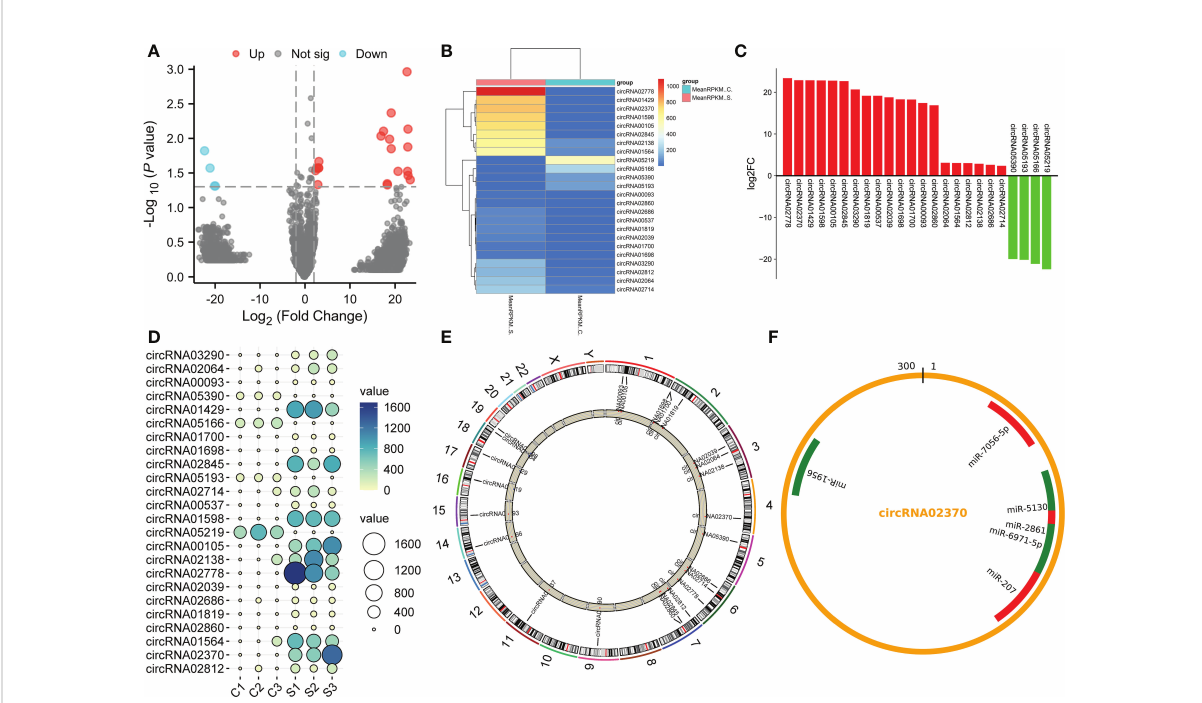
FIGURE 3 The circRNAs were differentially expressed in the subacute stage after SCI in mice. (A) Volcano plot. Green points indicate down-regulation (left side), gray points indicate undifferential expression (middle), and red points indicate up-regulation (right side). (B) Hierarchical clustering. with rows indicating DECs and columns indicating samples. (C) Bar plot shown the top 20 upregulated and 4 downregulated DECs in SCI tissues. The X-axis represents miRNA and the Y-axis represents log2 fold change. Red means up-regulation, above the X-axis; green means down- regulation, below the X-axis. (D) Ballon plot. The size of the circle shows the size of each value in the matrix, and the size of the value is represented by the shade of color. (E) The distribution of DECs on chromosomes. (F) CircRNA targeted miRNA distribution circle. The orange circle represents circRNA, and the red segment represents miRNA.